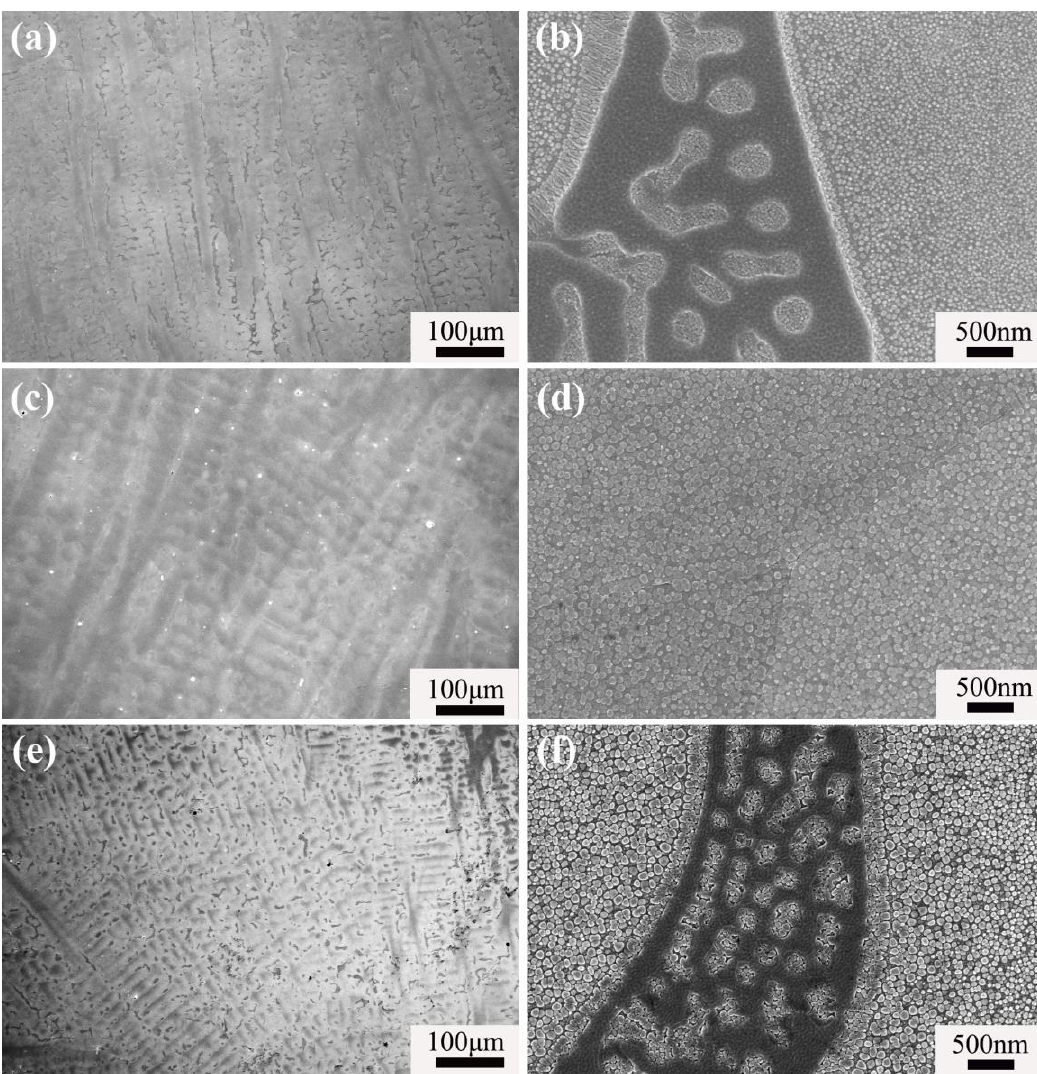
Figure 2. Secondary electron (SE) images of the three HEAs in the as-cast state. ( a , b ) B0.5 HEA; ( c , d ) Mg0.5 HEA; ( e , f ) Zr0.5 HEA. All alloys are shown at both low and high